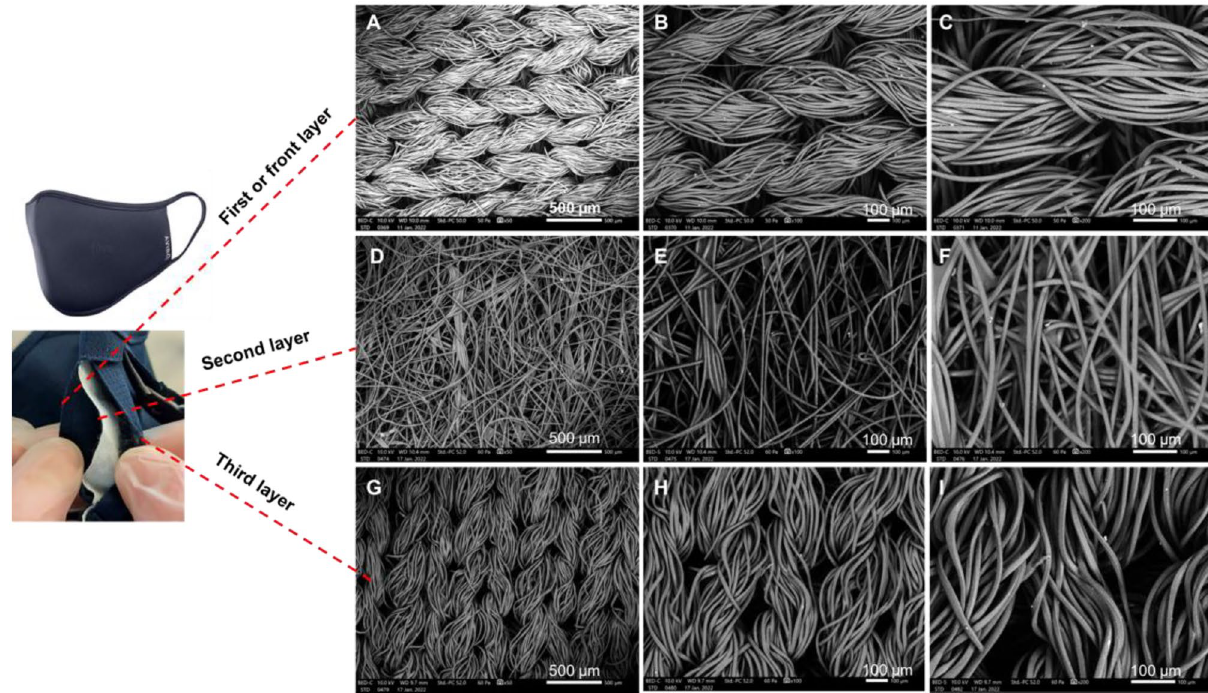
Figure 5. SEM for each of the three layers of an antiviral face mask. ( A – C ) first or front layer. ( D – F ) second layer. ( G – I ) third layer.